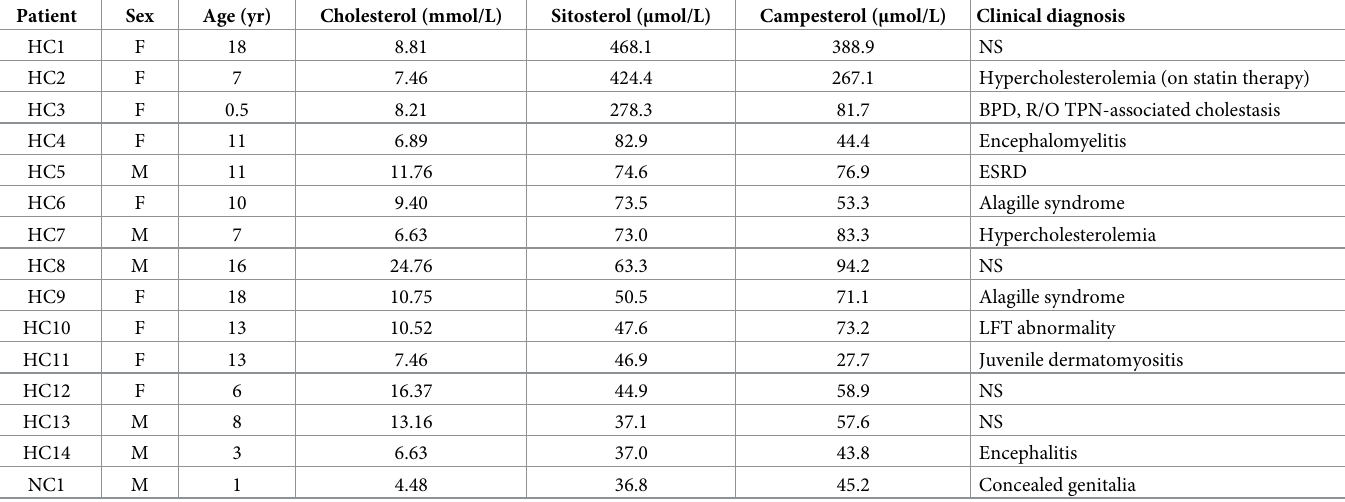
Table 3. Basic clinical data of hypersitosterolemic patients (in decreasing order of sitosterol concentrations). Patient